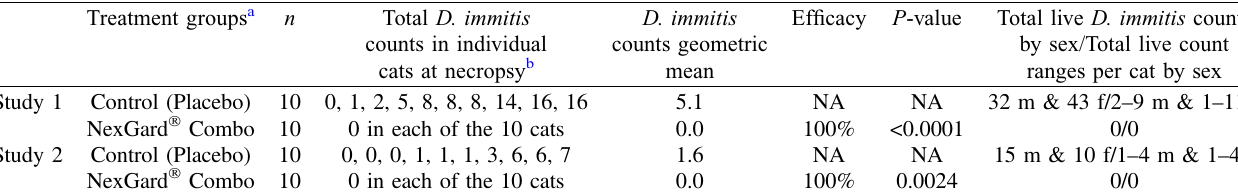
Table 2. Heartworm count per treatment group and ef fi cacy of NexGard (cid:1) Combo against D. immitis in cats. Treatment groups